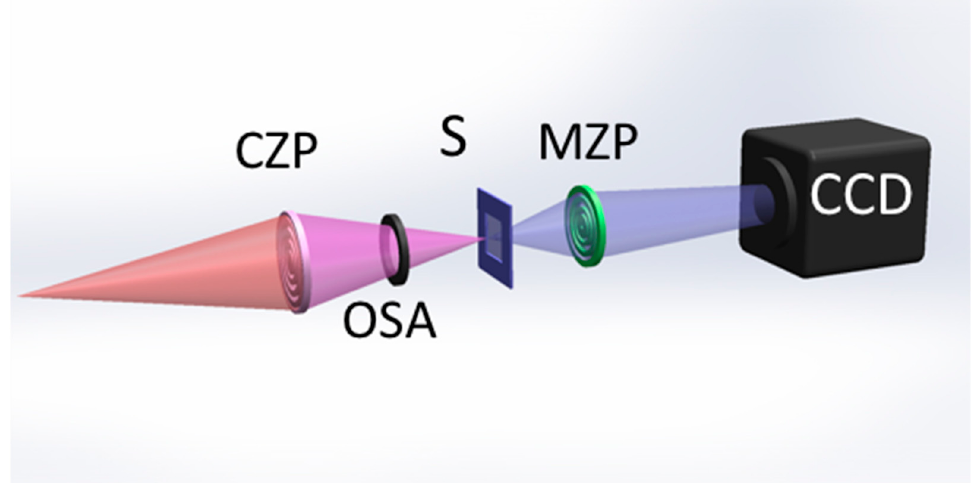
Figure 3. Schematic view of the TwinMic full field imaging mode setup, with a condenser ZP (CZP) illuminating the specimen (S), an order-selecting aperture (OSA), and a micro zone plate (MZP) that magnifies the image of the specimen into the detector with a directly illuminated CCD camera.